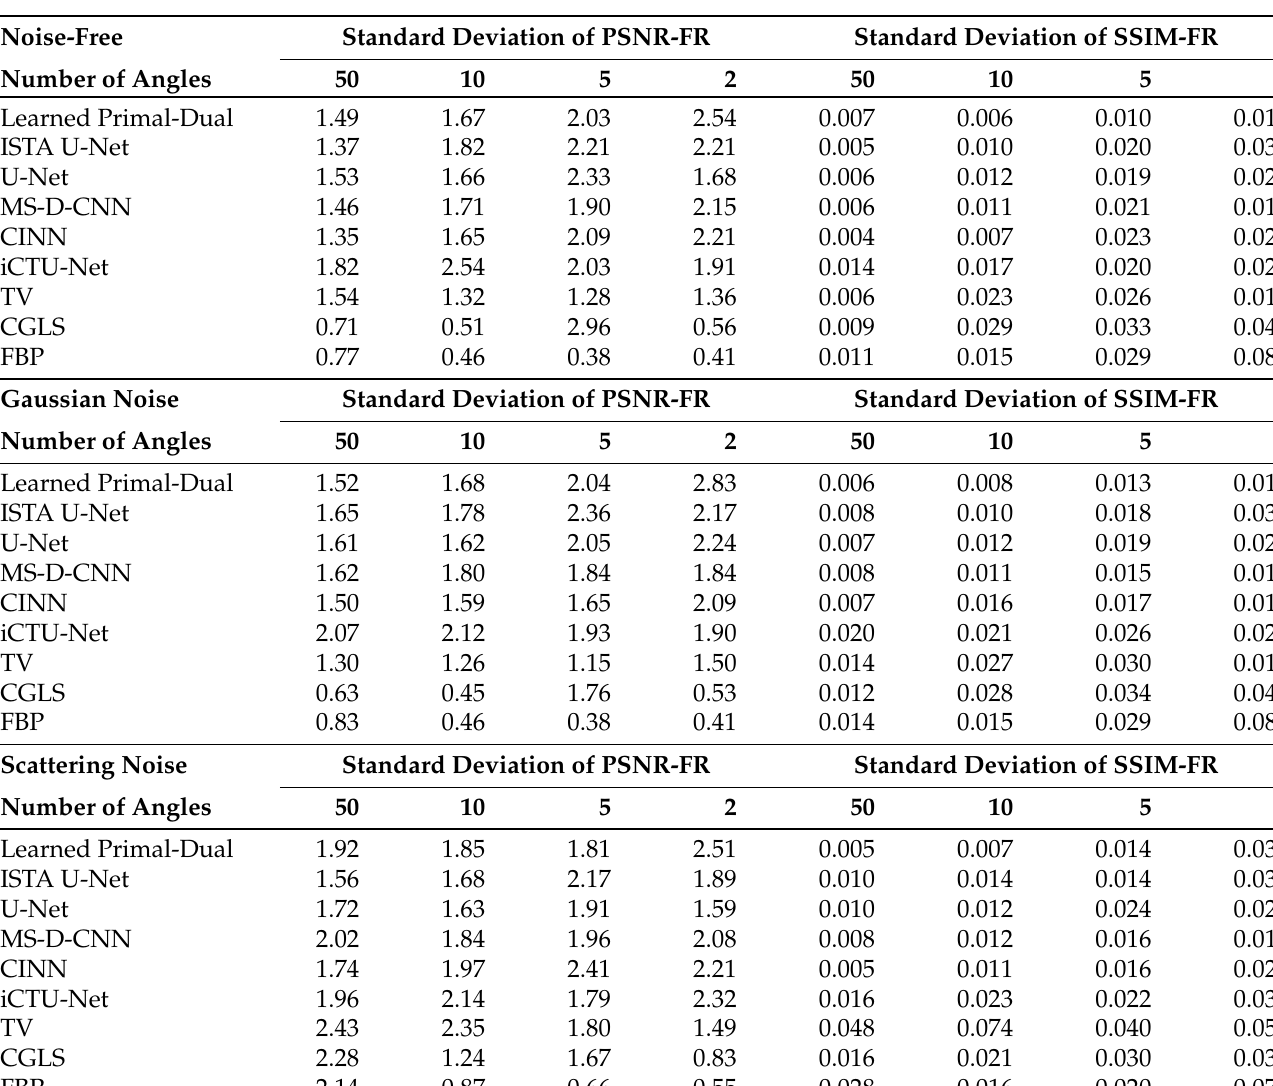
Table A5. Standard deviation of PSNR-FR and SSIM-FR (computed with fixed data range 0.0129353 for all images) for the different noise settings on the 100 selected Apple CT test